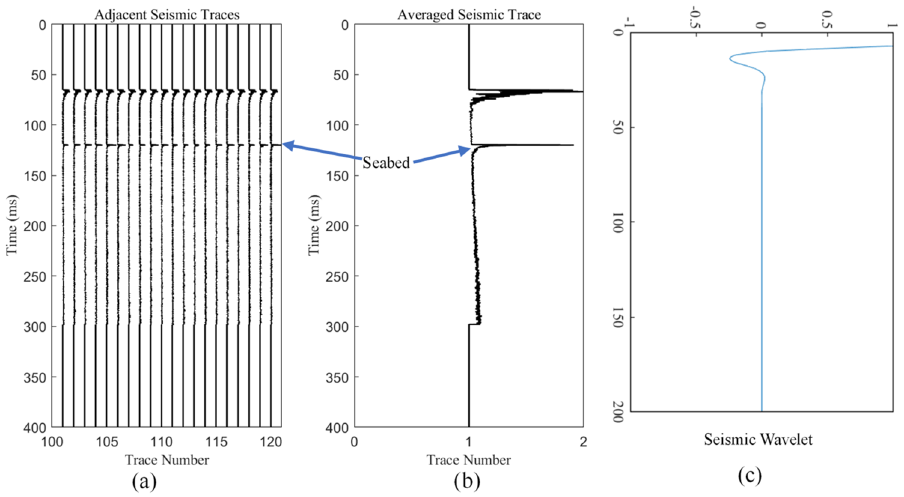
Figure 4. Averaging of the sub-bottom profile track data and the obtained wavelet: ( a ) the extracted adjacent traces with good lineup consistency; ( b ) the averaged seismic trace; ( c ) the wavelet obtained by logarithmic decomposition.